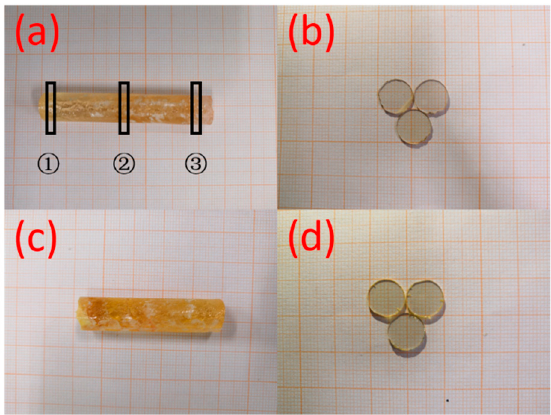
Figure 1. Samarium-doped La 3 Nb 0.5 Ga 5.5 O 14 (Sm:LGN) crystals grown by the Bridgman method. ( a ) and ( b ) La 0.9 Sm 0.1 GN, ( c ) and ( d ) La 0.8 Sm 0.2 GN.